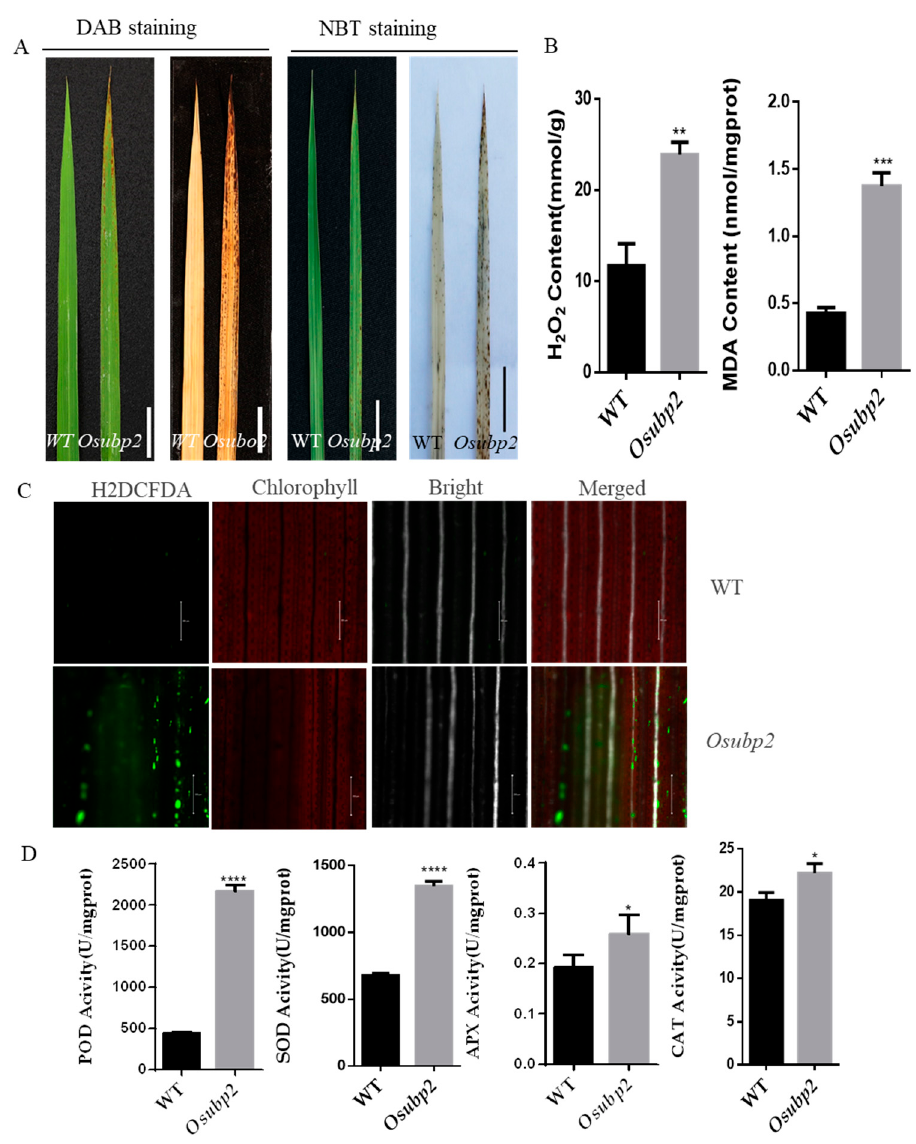
Figure 4. Mutation of OsUBP2 led to reactive oxygen species (ROS) accumulation. ( A ) 3,3 ′ -diaminobenzidine (DAB) and nitro blue tetrazolium (NBT) staining of the wild type (WT) and Osubp2 mutant leaves at 30 days post-sowing (dps). Scale Bar = 2 cm. ( B ) The content of hydrogen peroxide (H 2 O 2 ) and malondialdehyde (MDA) in WT and Osubp2 mutant leaves at 30 dps, mgprot: protein per milligram. ( C ) Microscopic analysis of leaves of the WT and Osubp2 mutant leaves at 30 dps, incubated with 2 ′ ,7 ′ -dichlorofluorescein diacetate (H 2 DAFDA). Red, chlorophyll; green, oxidized H 2 DCFDA. Scale Bar = 200 μ m. White: white light channel; Merged: image color merged channel. ( D ) The peroxidase (POD), superoxide dismutase (SOD), ascorbate peroxidase (APX) and catalase (CAT) enzyme activity in WT and Osubp2 mutant leaves at 30 dps. Error bars represent + SD ( n = 3 independent pools of leaves, three plants per pool). Asterisks indicate significant difference between Osubp2 mutant and WT by Student’s t-test: **** p < 0.0001; *** p < 0.001; ** p < 0.01; * p < 0.05.